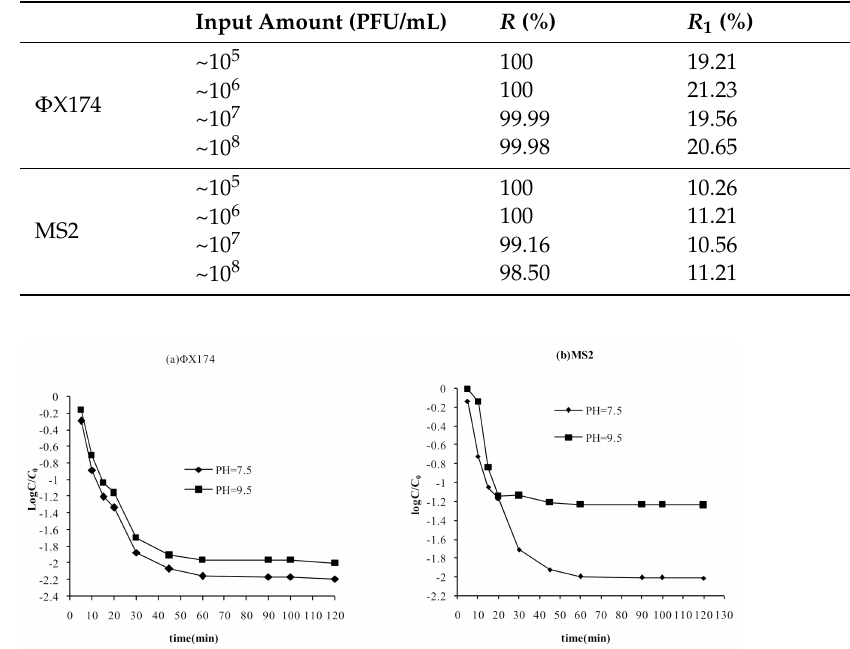
Table 3. Virus removal and recovery at different initial concentrations.